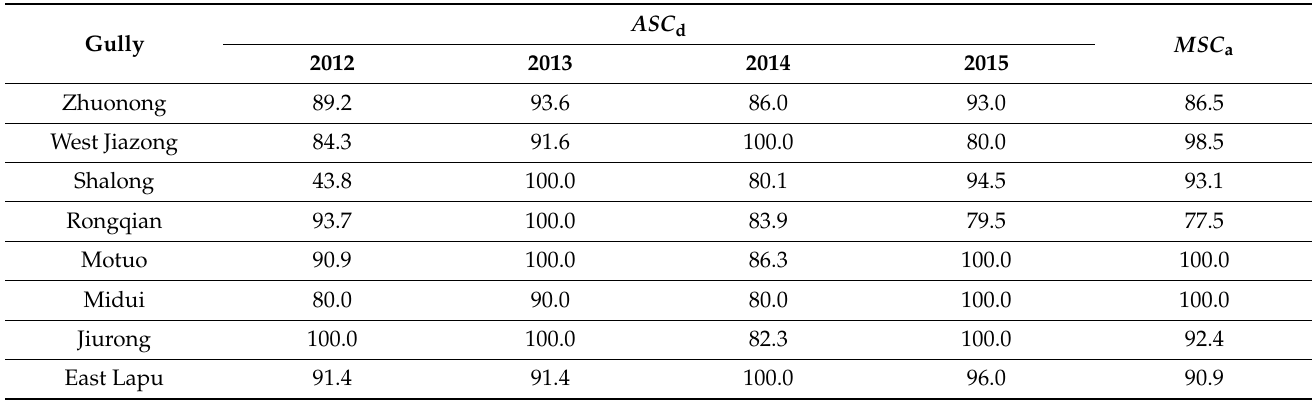
Table 7. Snow cover conditions of the eight debris flow gullies at training and validation phase in 2012–2015 (unit: